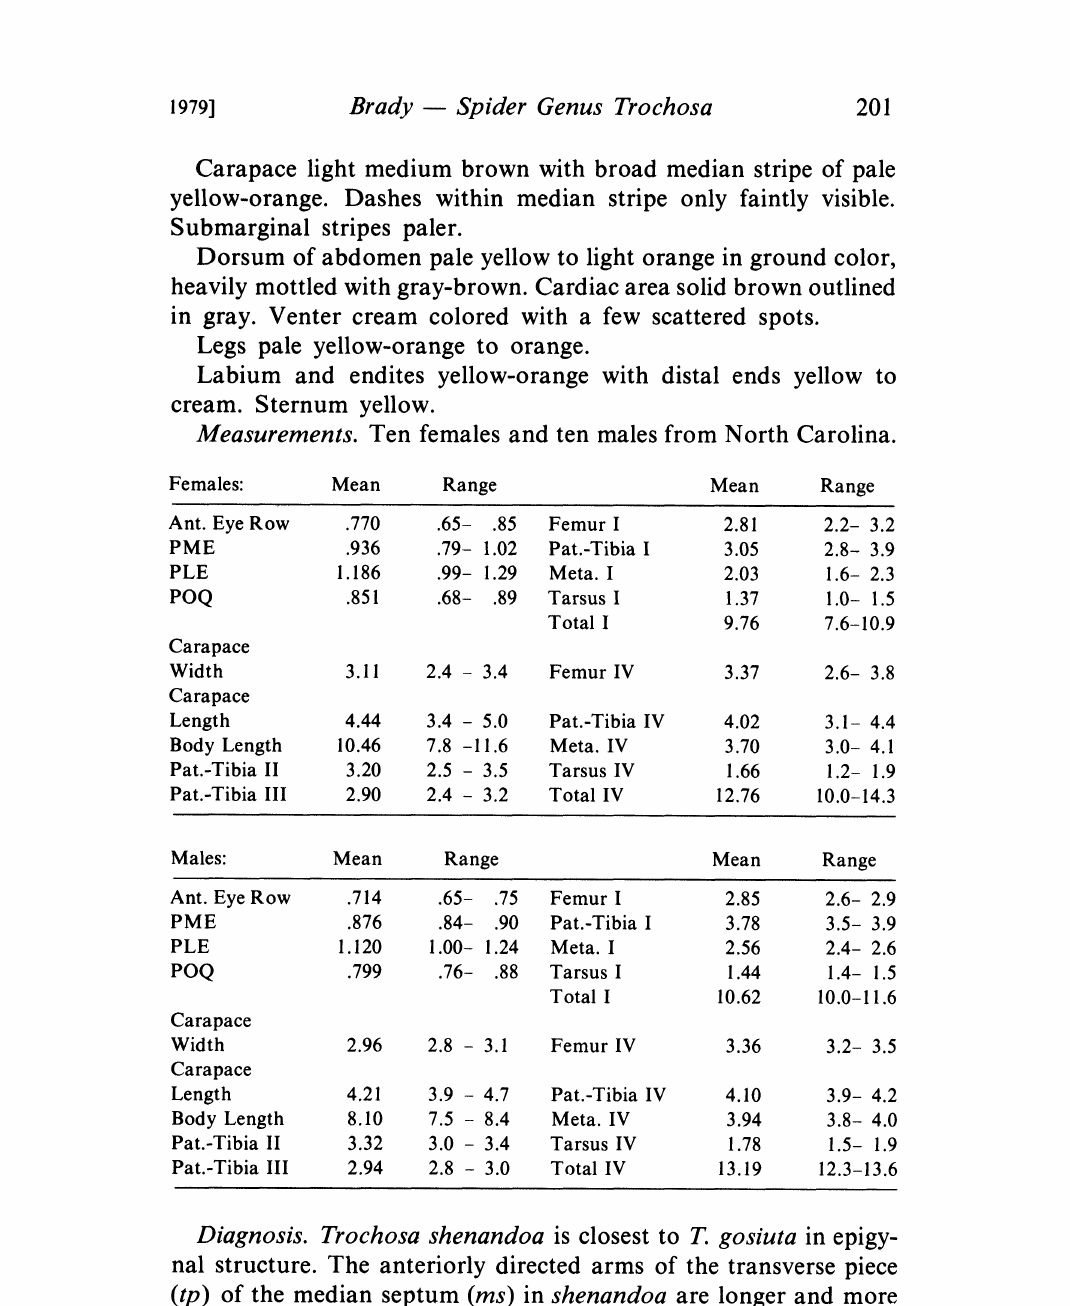
Diagnosis. Trochosa shenandoa is closest to T. gosiuta in epigy- nal structure. The anteriorly directed arms of the transverse piece (tp) of the median septum (ms) in shenandoa are longer and